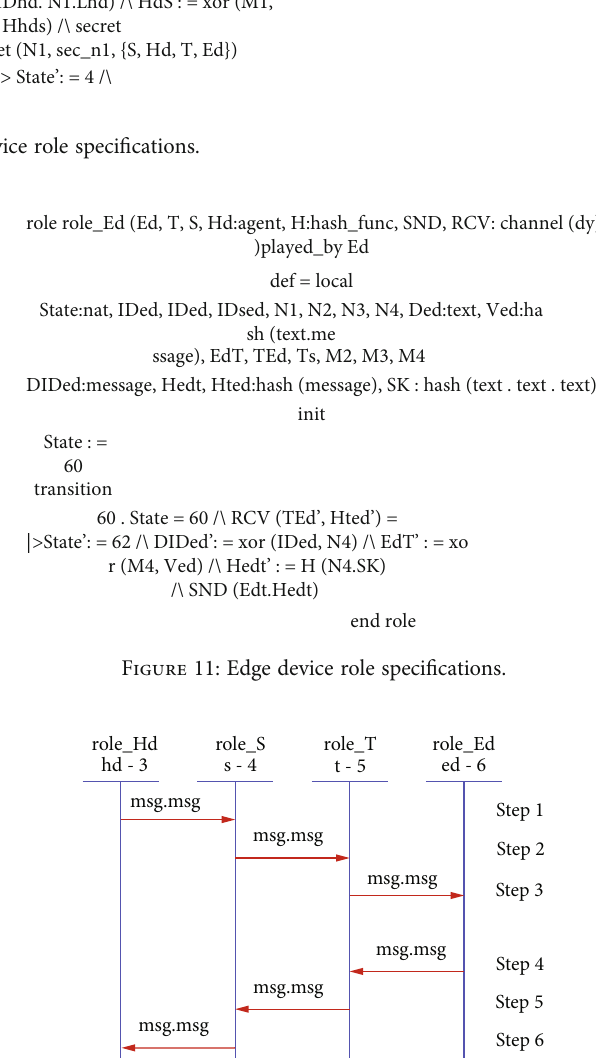
Figure 12: Smart emergency medical response system protocol simulation on SPAN.